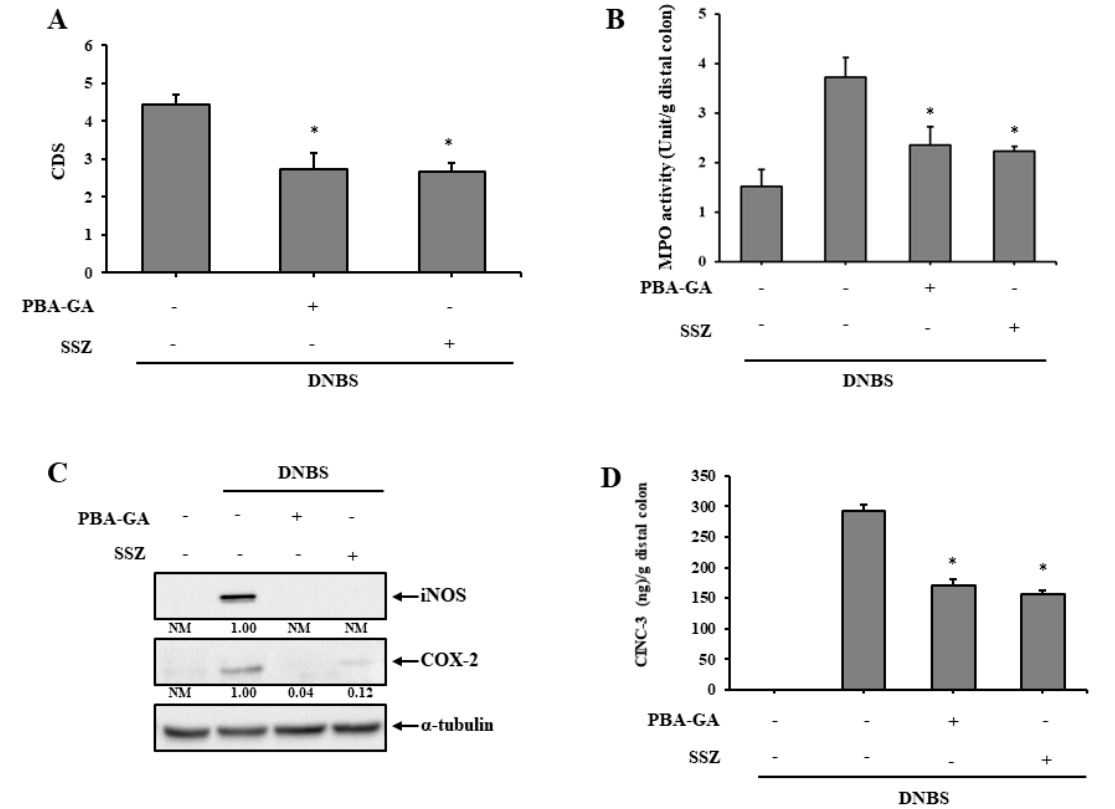
Figure 4. PBA-GA is as effective as sulfasalazine (SSZ) in ameliorating DNBS-induced rat colitis.( A - D ) Three days after the induction of colitis, PBA-GA (53.6 mg/kg, equivalent to 30.0 mg/kg of 4-PBA) dissolved in 1.0 mL of PBS and SSZ (30.0 mg/kg) suspended in 1.0 mL PBS (pH 7.4) were administered orally to rats once daily. The rats were sacrificed after the seventh dose. ( A ) The colonic damage score (CDS) was determined for each group as described in the “Materials and Methods” section. ( B ) Myeloperoxidase (MPO) activity was measured in the inflamed distal colons (4.0 cm). Levels of inflammatory mediators, including ( C ) iNOS, COX-2 and ( D ) CINC-3, were measured in the inflamed colon. α -Tubulin was used as a loading control to normalize the levels of iNOS and COX-2. The data represent the means ± SD ( n = 5). * p < 0.05 vs. DNBS control, NM: not measurable.